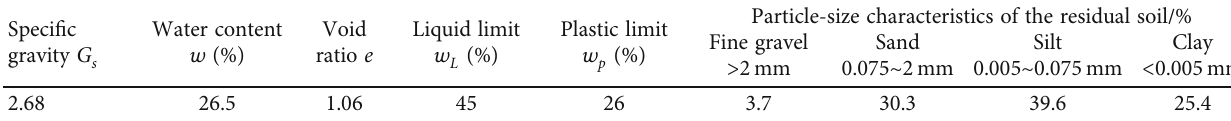
Table 2: Physical and mechanical properties of residual